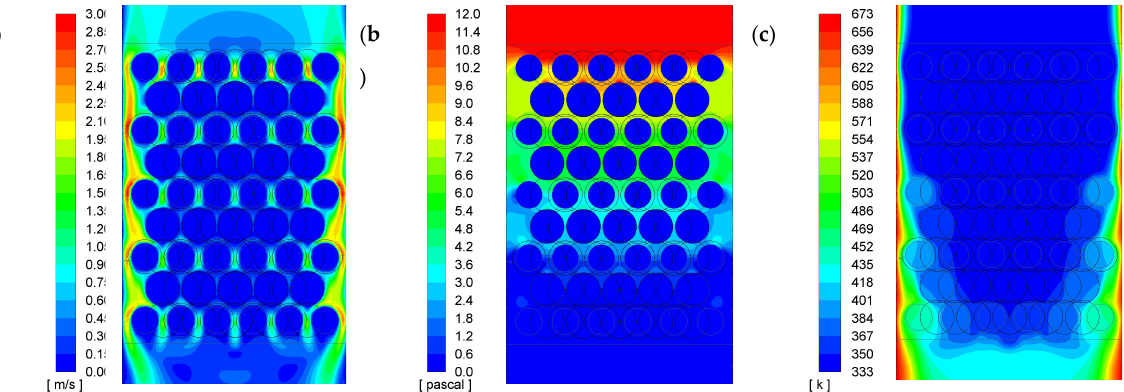
Figure 7. Cross-section of the computational mesh in the porous medium zone.